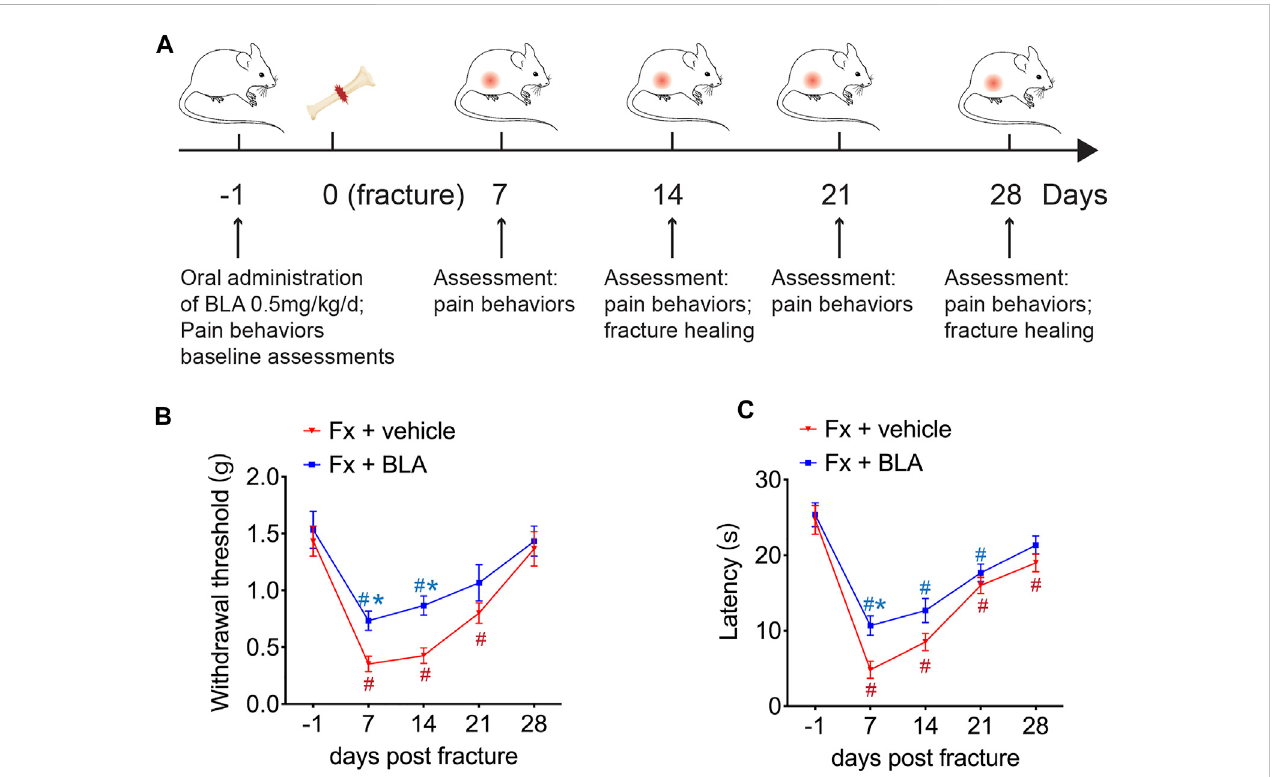
FIGURE 1 Effects of BLA on mechanical and thermal hyperalgesia after fracture. (A) Schematic showing the experimental protocol. (B) Paw withdrawal threshold responding to von Frey fi laments was tested at the fractured hind paw of BLA or vehicle treated fracture (Fx) mice. N = 6 per group. (C) Thermal nociceptive withdrawallatencyassessingthermalhyperalgesiawastestedatthefracturedhindpawofBLAorvehicletreatedfracture(Fx)mice. N =6pergroup.Valuesare expressed as mean ± SEM. Two-way repeated-measures ANOVA, Dunnett ’ s multiple-comparisons test for differences within each group: # p < 0.05 when compared with baseline (day-1); Bonferroni ’ s multiple-comparisons test for differences between groups: * p < 0.05 when compared with vehicle